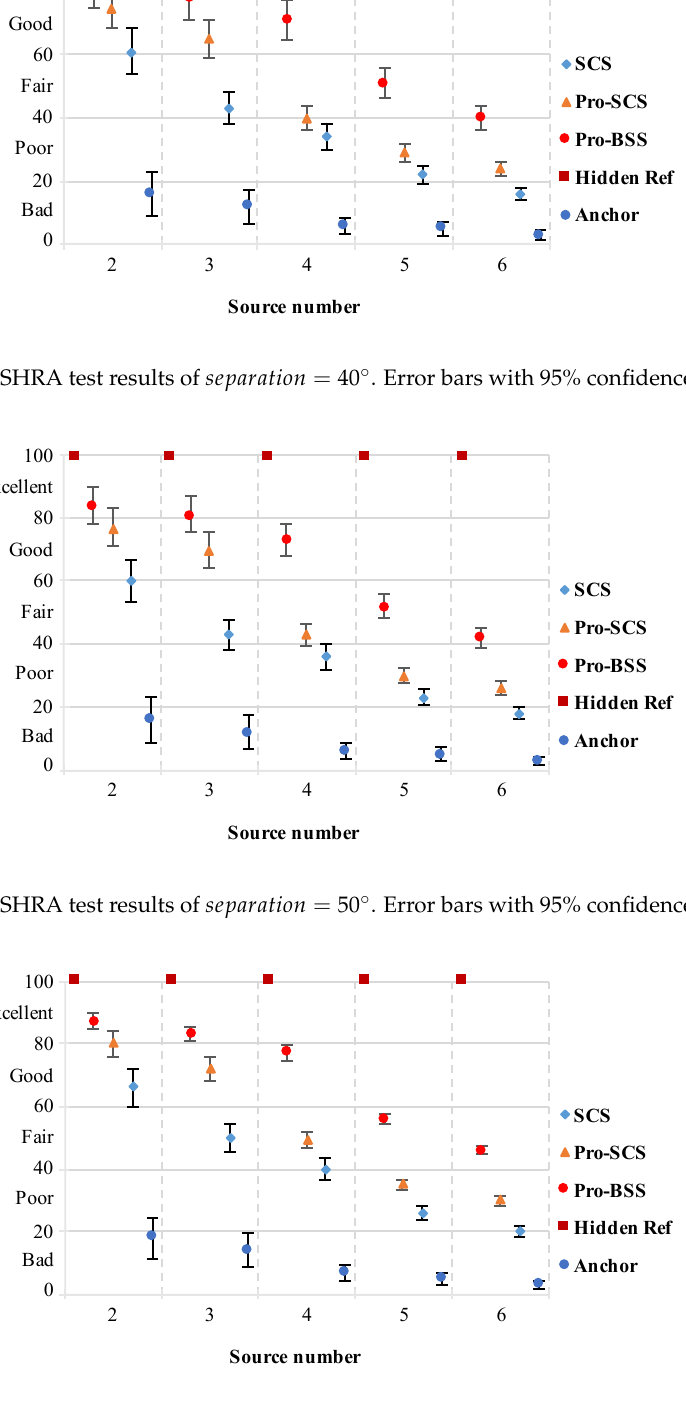
Figure 16. MUSHRA test results of separation = 60 ◦ . Error bars with 95% confidence